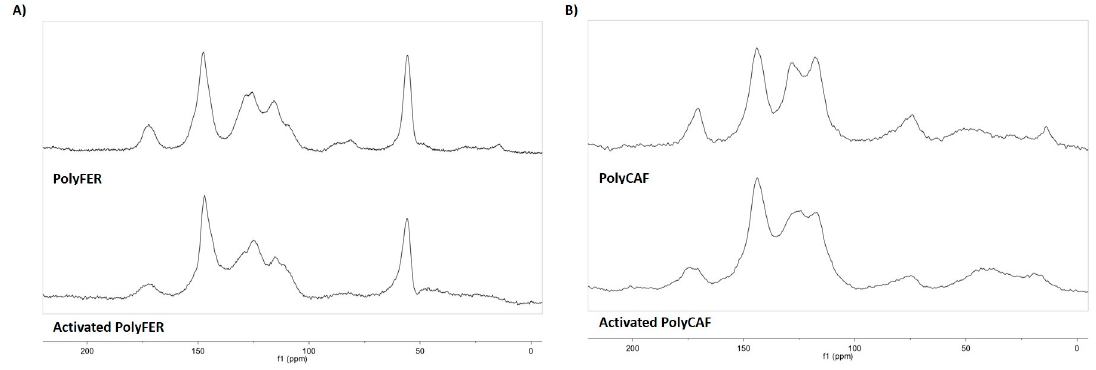
Figure 7. 13 C CP-MAS NMR of ( A ) PolyFER and ( B ) PolyCAF before (top) and after (bottom) hydrolytic treatment. Antioxidants 2020 , 9 , x FOR PEER REVIEW